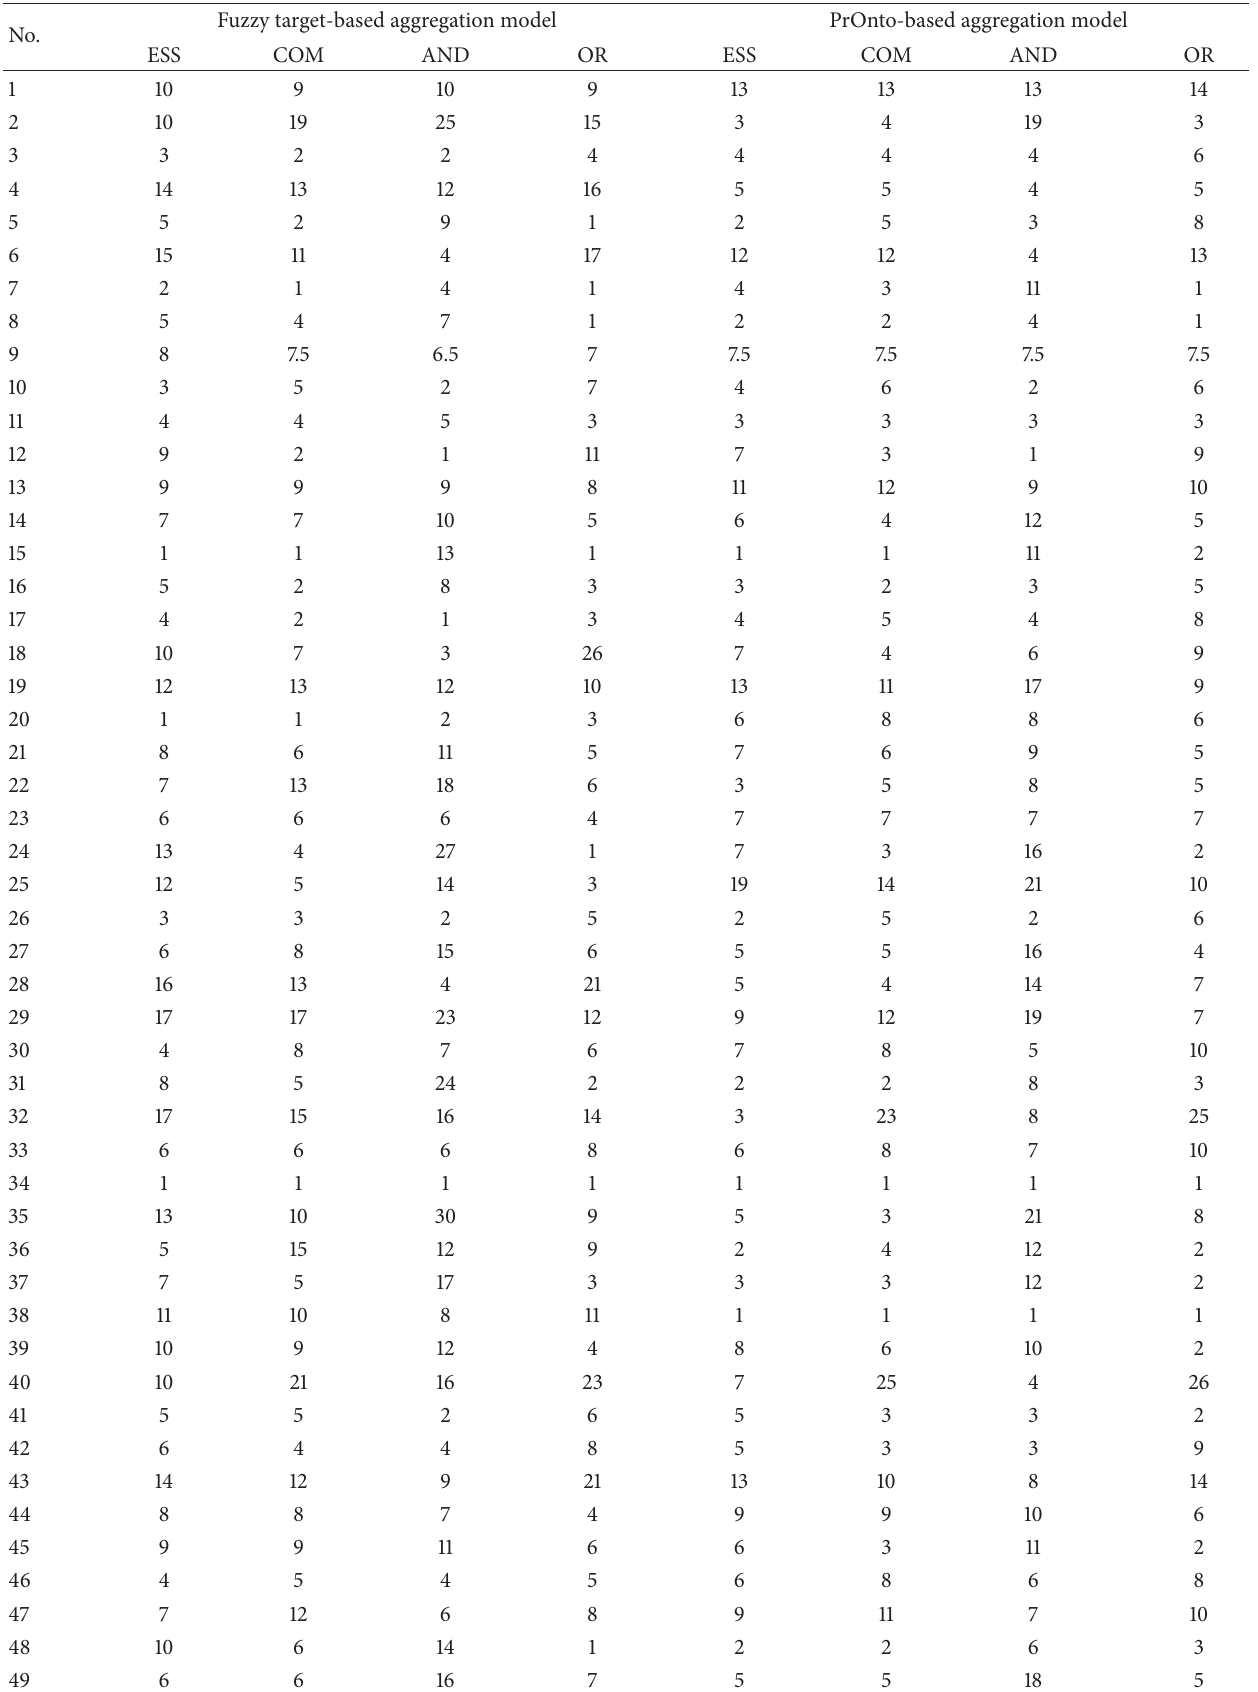
Table 2: Comparison results of different aggregation models and ranking